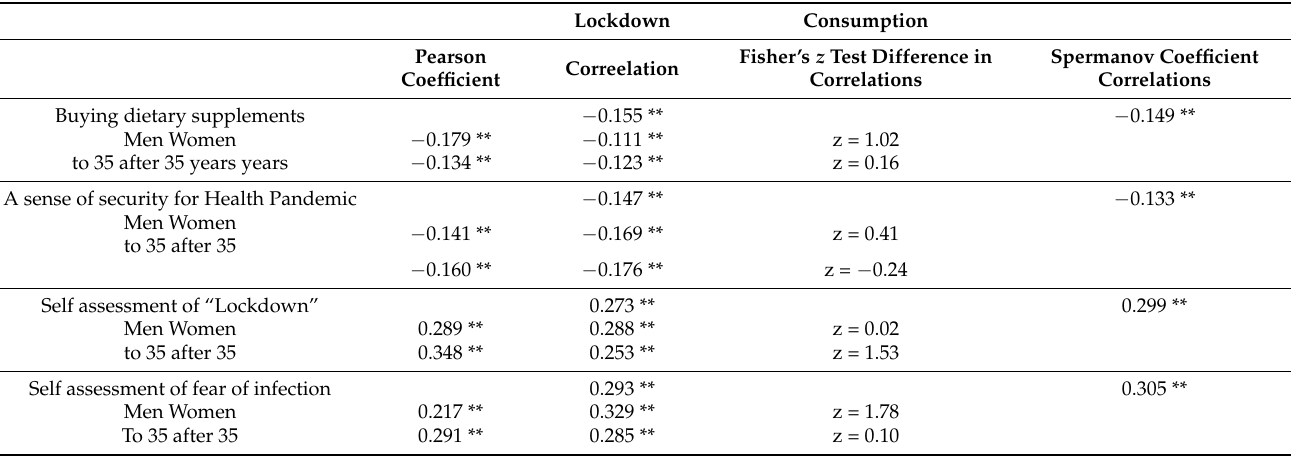
Table 5. Relationships of self-assessment of the impact of fear on patterns of behavior at the time of COVID-19 with variables of purchase of dietary supplements on the total sample (N = 257), male and female subsamples (NM = 104; NF = 153) and subsamples up to 35 years of age (N up to 35 years of age = 105) and after 35 years of age (N after 35 years of age = 152). Lockdown Consumption Pearson Fisher’s z Test Difference in Spermanov Coefficient Correelation Coefficient Correlations Correlations Buying dietary supplements